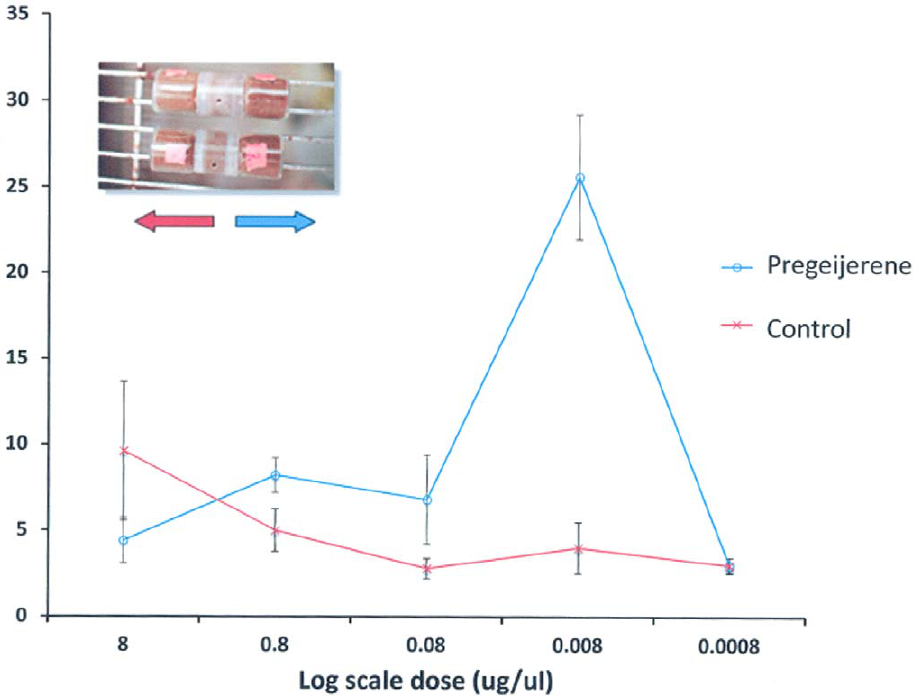
Figure 2. Optimal dosage of pregeijerene (1,5-dimethylcyclodeca-1,5,7-triene) for attracting entomopathogenic nematodes ( Steinernemariobrave and Heterorhabditisindica ) based on the log scale dilution of purified compound. Picture in upper left displays sand-filled two-choice olfactometers used for nematode bioassays.